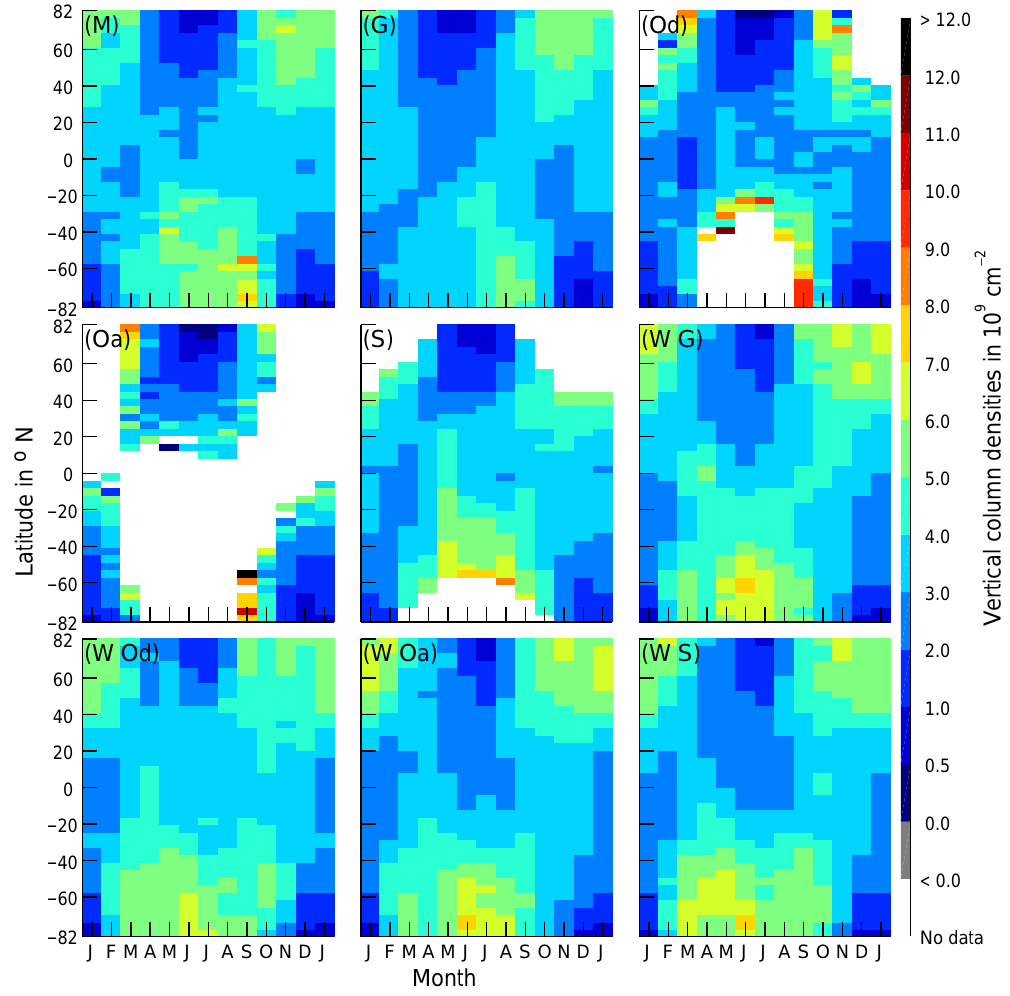
Figure 2. 2008–2012 multi-annual monthly mean vertical Na column densities between 76km and 106km altitude from different instruments and models. Ensemble mean (M), GOMOS (G), OSIRIS descending leg (Od), OSIRIS ascending leg (Oa), SCIAMACHY dayglow (S), WACCM colocated with the LT of ascending leg of GOMOS (W G), WACCM colocated with the LT of the descending leg of OSIRIS (W Od), WACCM colocated with the LT of the ascending leg of OSIRIS (W Oa), WACCM colocated with the dayglow measurements of SCIAMACHY and the descending leg of GOMOS (W